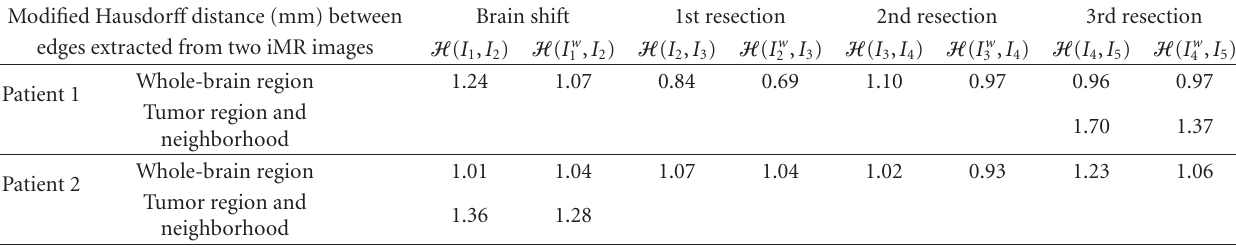
, I k +1 ), k = 1, ... ,4, for each deformation modeling based on a pair ( I k , I k +1 ) of two successive iMR Table 1: Values of H ( I k , I k +1 ) and H ( I w k images. First value gives measure of similarity of images rigidly registered, while second value gives measure of similarity of images both rigidly, and (subsequently) nonrigidly registered. For each I k , only the whole-brain region is taken into account for edge extraction. Modified Hausdor ff distance (mm) between Brain shift 1st resection 2nd resection 3rd resection edges extracted from two iMR images Whole-brain Patient 1